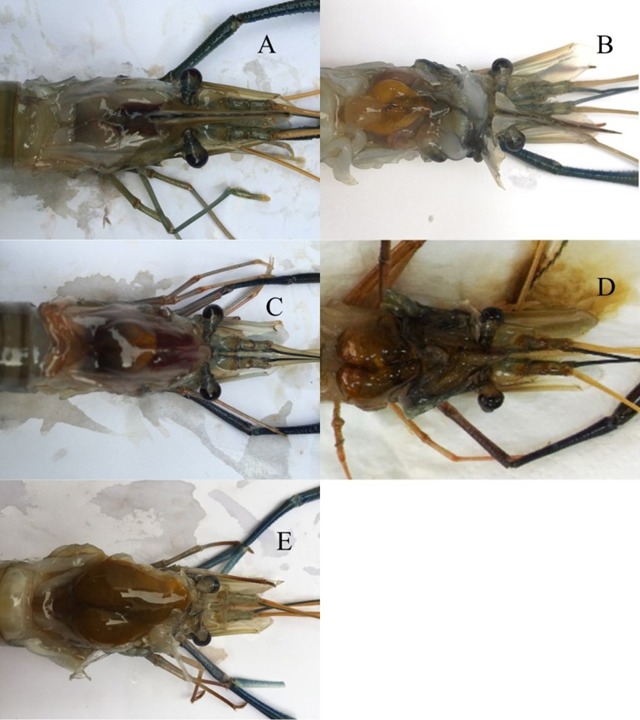
Descriptions of ovarian maturation stages of M. rosenbergii based on the criteria described in Damrongphol, Eangchuan & Poolsanguan (1991), Chang & Shih (1995) and Revathi et al. (2012). (A) Spent stage (Stage I). No ovarian tissue can be observed; this absence is characteristic of both non- developed and spent females. (B) Early previtellogenic stage (Stage II). The ovarian tissue is present as a small, yellow spot near the posterior part of the carapace. (C) Late previtellogenic stage (Stage III). Ovary, orange in color, can be observed from the posterior part of the carapace to the area just in front of the epigastric tooth. (D) Early vitellogenic stage (Stage IV). The orange ovarian tissues have grown and extended to the area of the epigastric tooth. (E) Late vitellogenic stage (Stage V). The ovarian tissues have extended to the anterior part of the carapace.